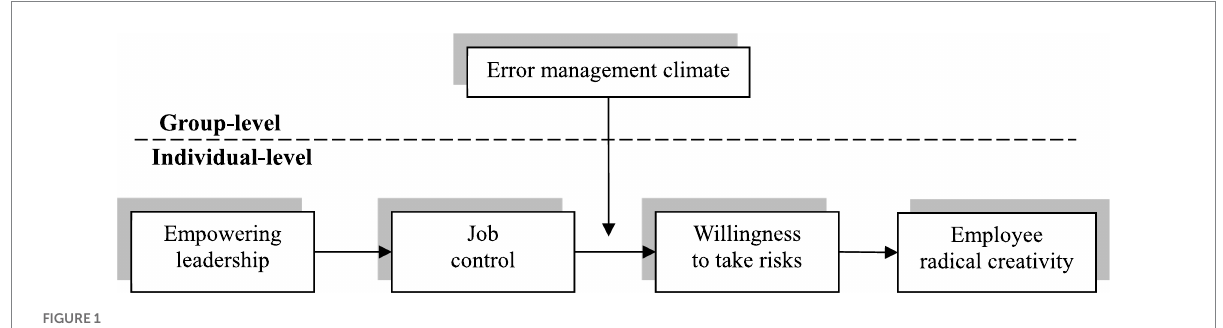
FIGURE 1 Proposed theoretical